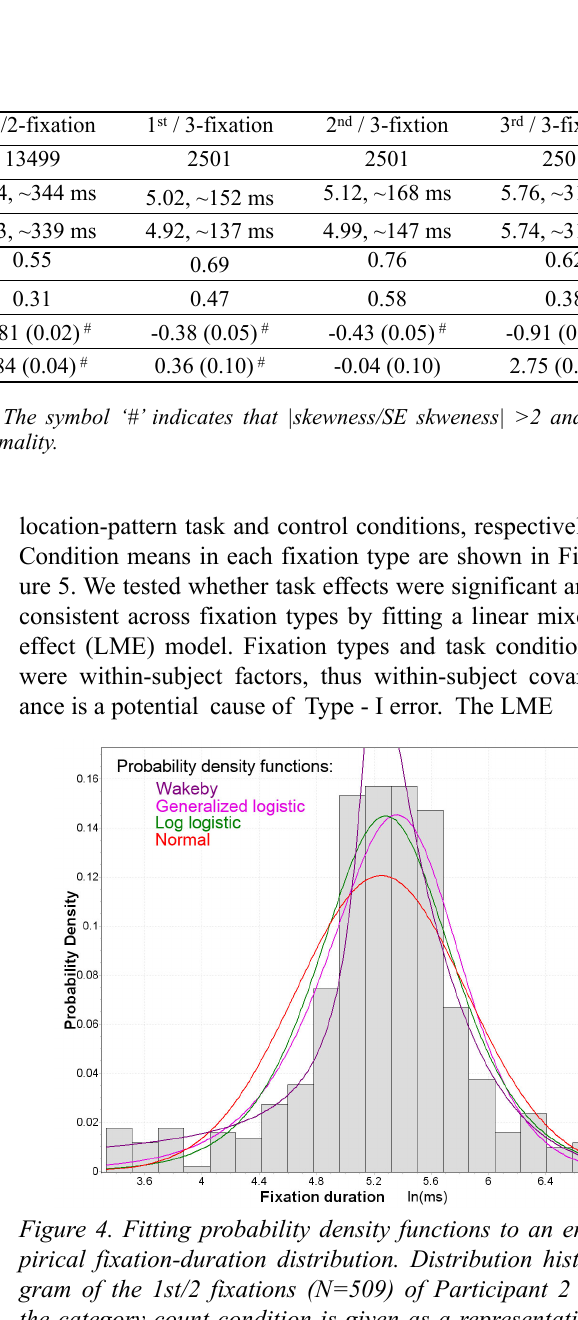
Table 2. Statistics of six fixation types